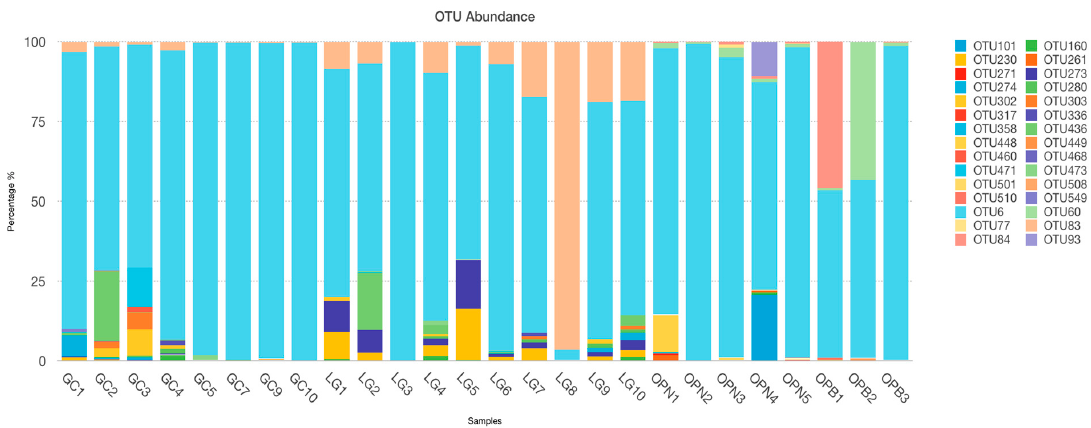
Figure 4. Percentages of OTU abundance (read numbers) per orchid samples. GC = Gran Canaria; LG = La Gomera; OP = Orchis patens (Liguria).